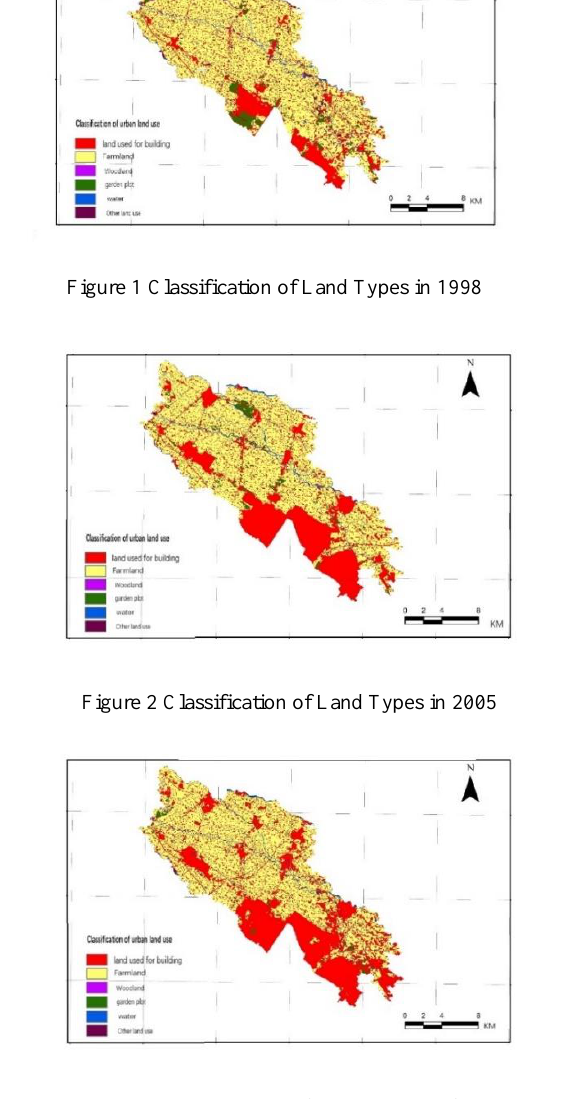
Figure 3 Land Type Classification Results for 2012